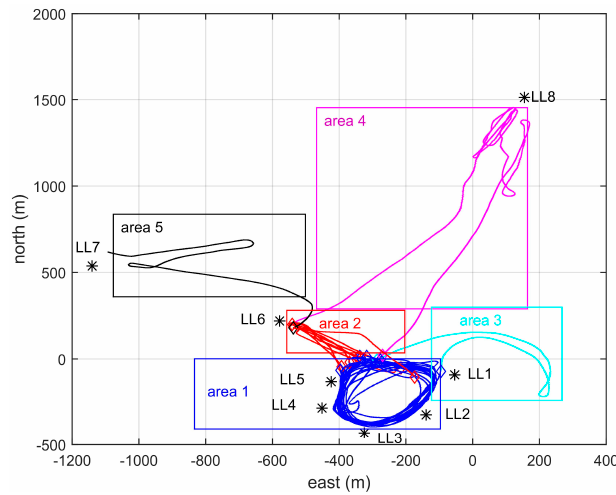
Figure 5. Location of LocataLites and experiment trajectory.